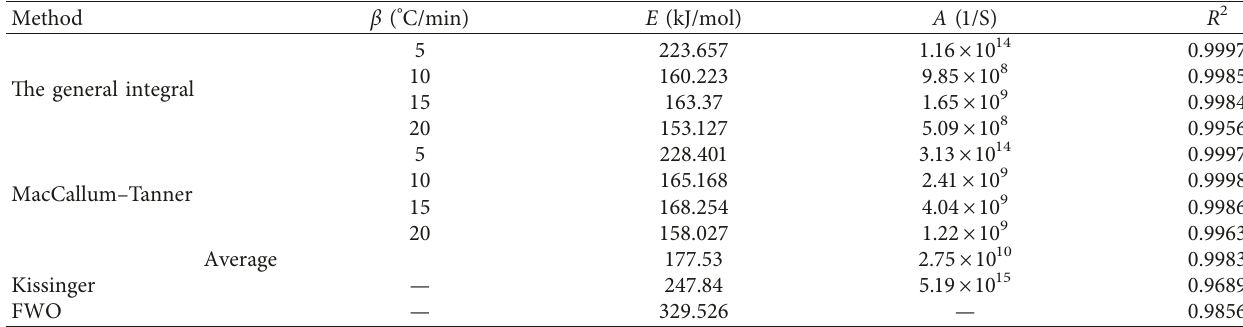
Table 3: Calculation results of coal SJC.